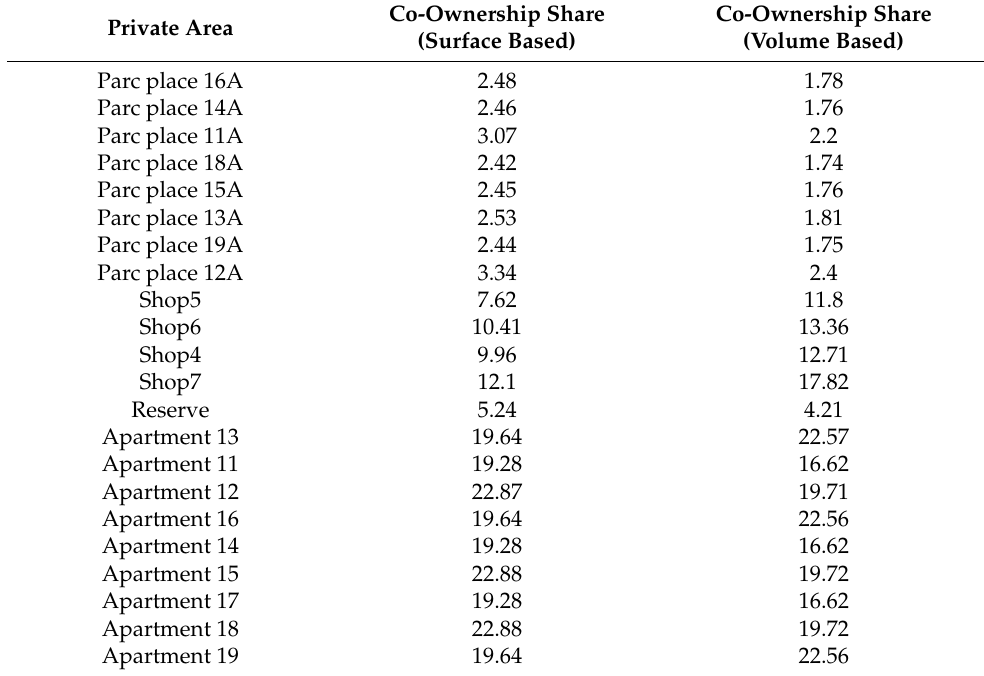
Table 1. Comparison of co-ownership shares based on volume and